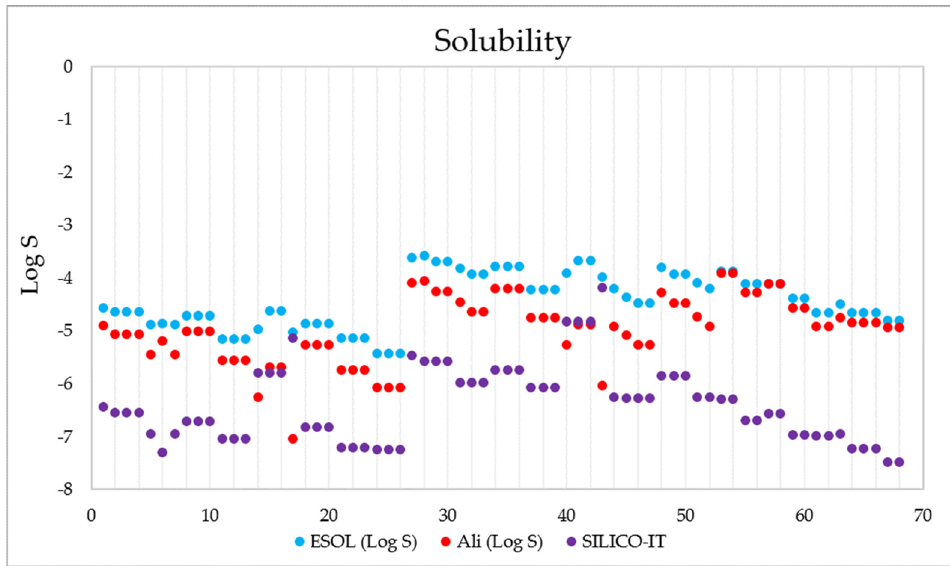
Figure 11. Solubility data (in Log S) calculated for the 68 1,4-naphthoquinone derivatives using the ESOL (blue), Ali-adapted (orange), and SILICO-IT (magenta) methods. The evaluation of pharmacokinetic parameters of gastrointestinal (GI) absorption, P-gp substrate, and cytochrome P450 (CYP) inhibition or interaction for all 68 derivatives is presented in Figure 12.